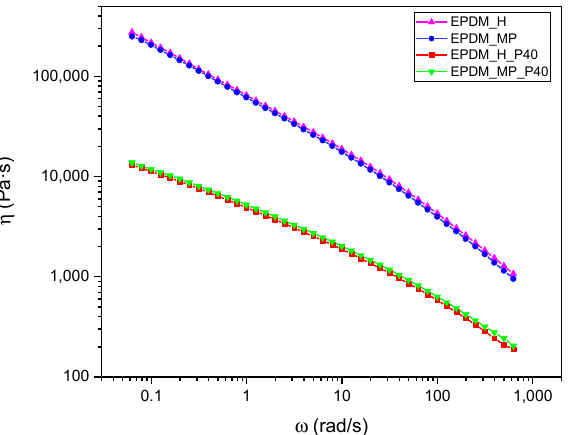
Figure 7. Dynamic rheological curves on the not-vulcanized EPDM mixtures. Complex viscosity ( η *) as a function of angular frequency ( ω ) for EPDM_H, EPDM_MP, EPDM_H_40, and EPDM_MP_P40 samples.